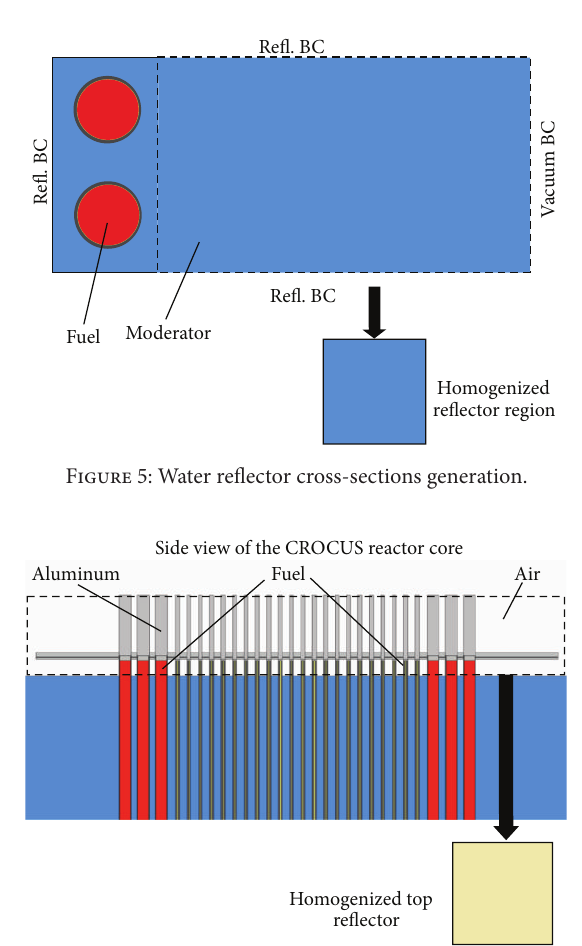
all U-metal nodes by increasing the fuel pitch from 2.917 to 3.023 cm. In a similar way, when the water gap is contained in the inner lattice, the UO 2 pitch is increased from 1.837 to 1.909